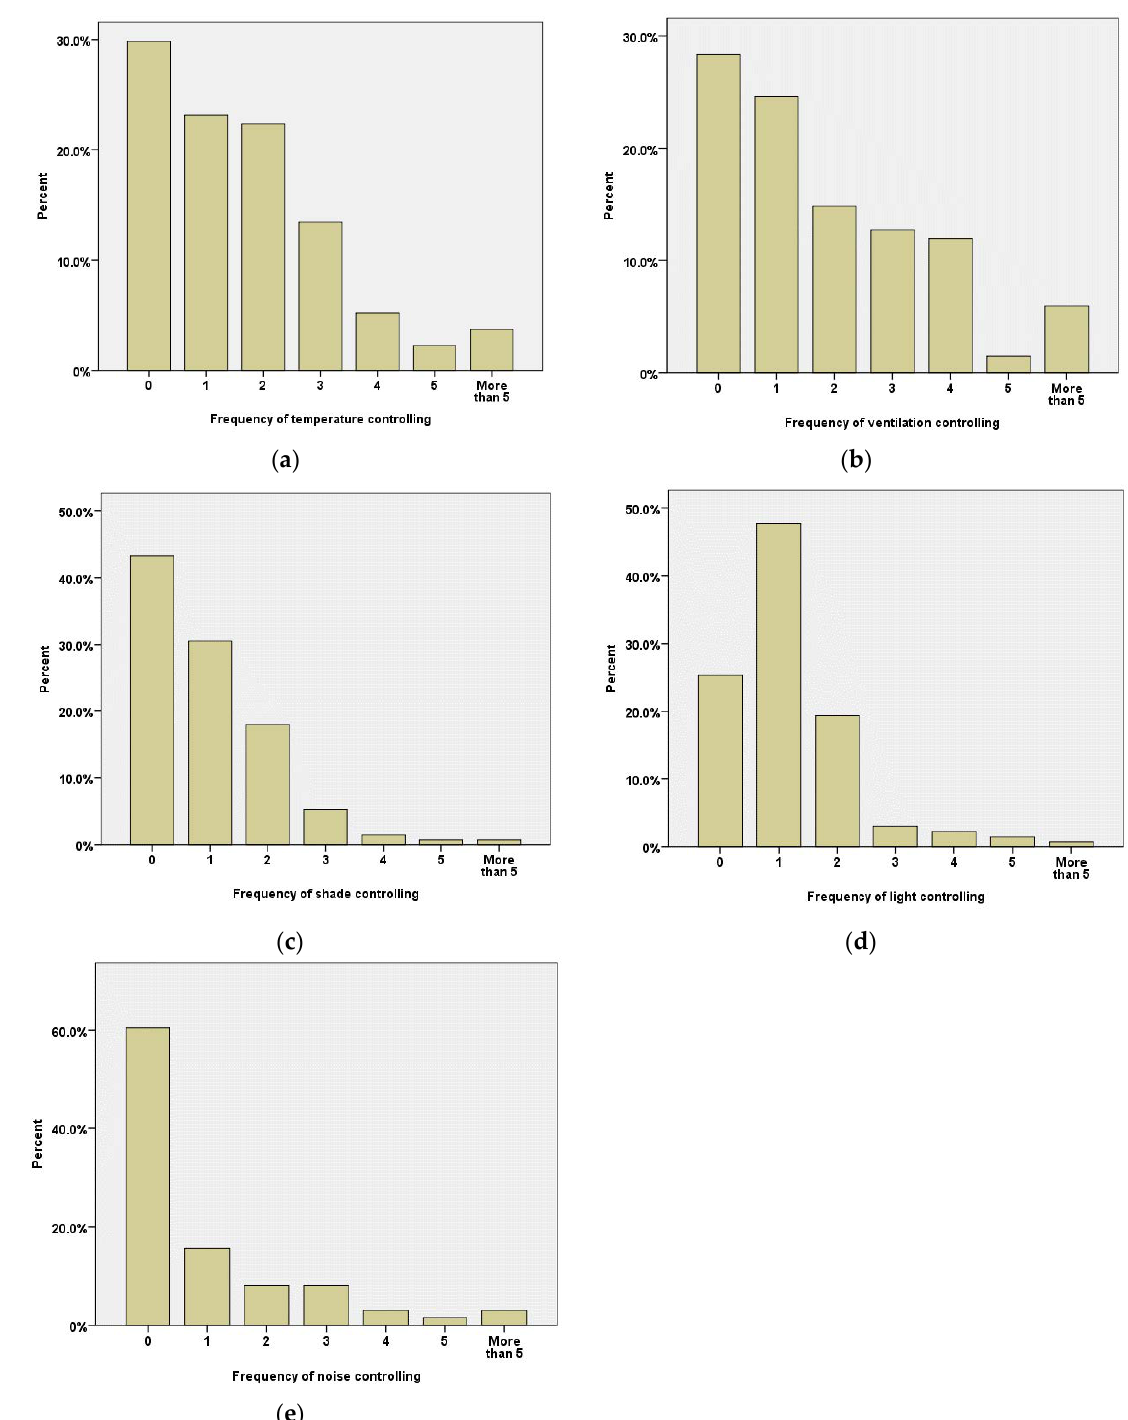
Figure 5. Frequency of controling ( a ) temperature, ( b ) ventilation, ( c ) shade, ( d ) light and ( e ) noise.